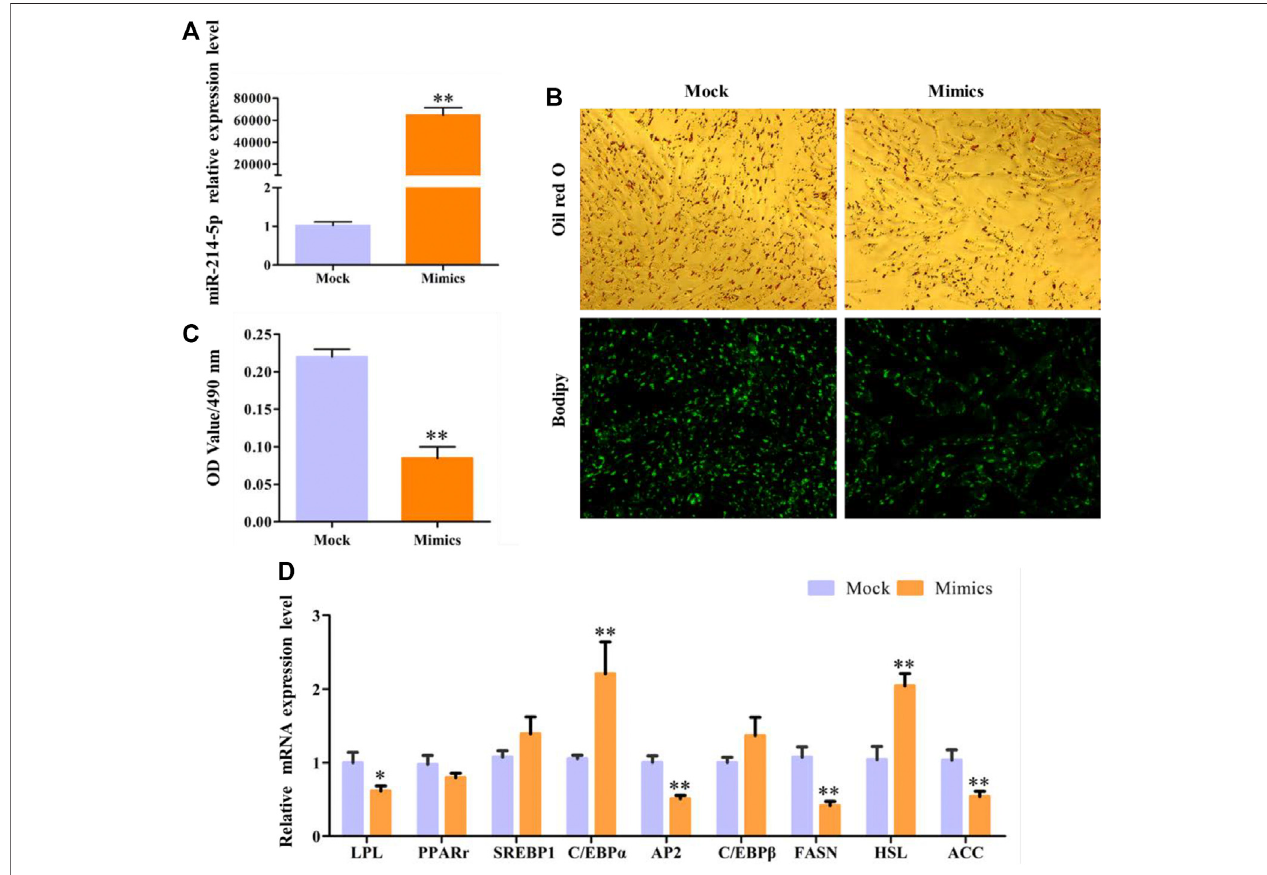
FIGURE 3| Overexpression of miR-214-5p restrained goat intramuscular adipocyte differentiation. (A) Ef fi ciency ofmiR-214-5p mimics. (B) Oil red O staining and Bodipy staining ( × 200). (C) OD value at 490 nm. (D) mRNA expression levels of key adipogenic regulatory genes after transfection with miR-214-5p